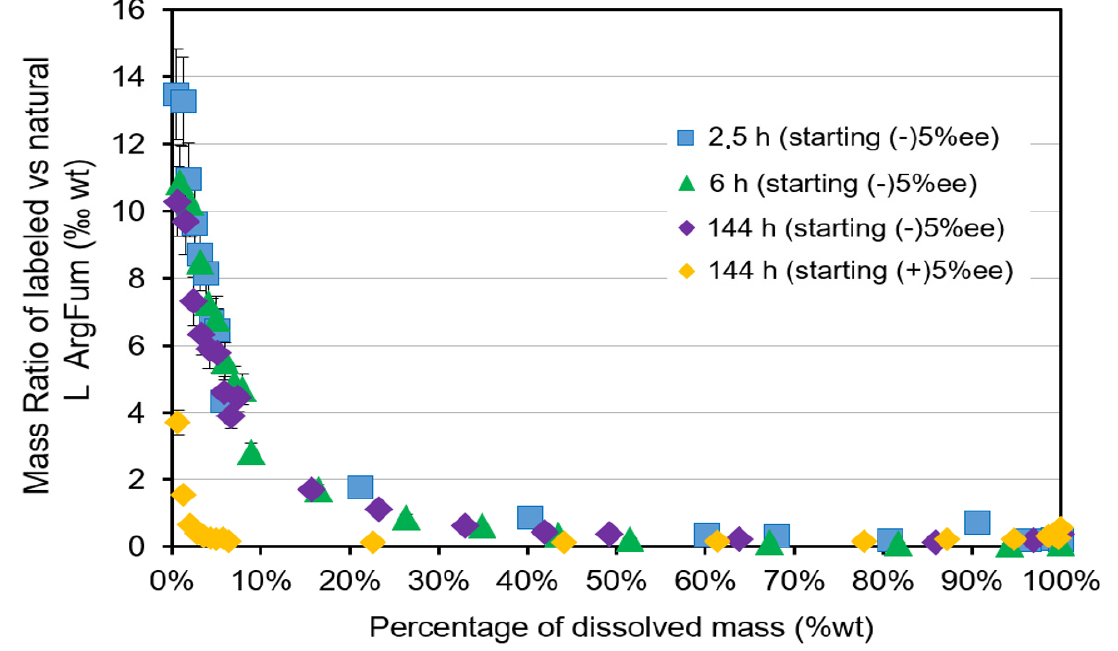
Figure 6. Profile of L-labeled arginine in the different layers of the deposited crystals as obtained by rewinding PE experiments starting from ( − )-5%ee and with L(+)-labeled arginine added after 2.5 h (blue squares), 6 h (green triangles) and 144 h (purple lozenge). The orange lozenges stand for the PE initiated with (+)-5%ee and doped 144 h after the process started. The Y-axis represents the mass of 13 C µ g) by the mass of natural L-arginine (mg) detected in the crystals at a given time 6 -L-arginine ( (‰ ratio). Error bars are smaller than the size of the experimental